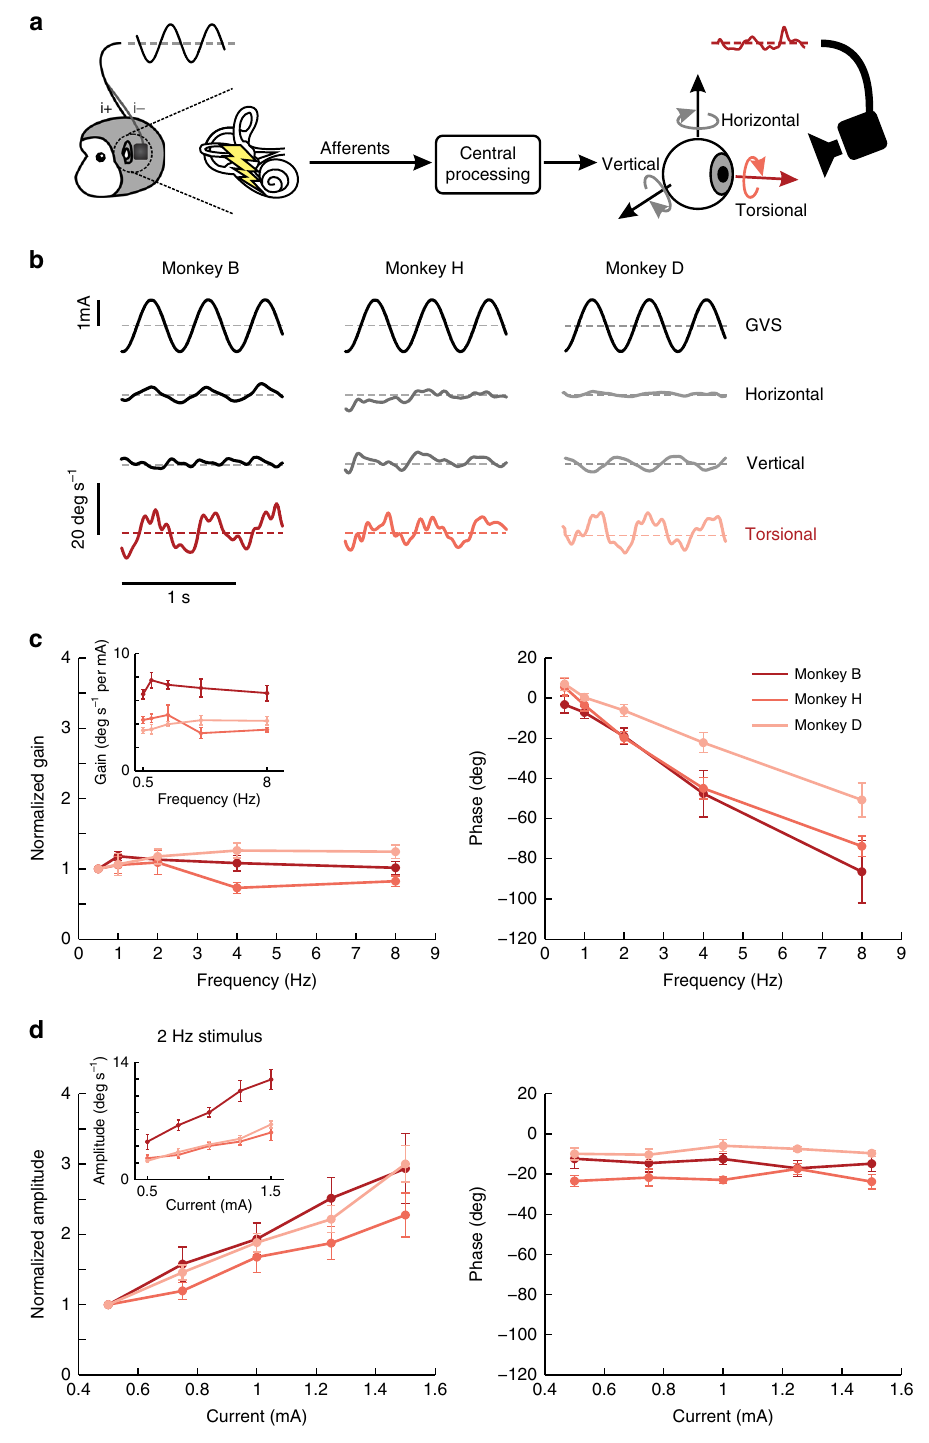
Fig. 1 Torsional eye movements in response to sinusoidal GVS. a While applying sinusoidal GVS between surface electrodes placed on the mastoid processes behind the ears, we recorded the animal ’ s eye movements while it was fi xating. b Example traces of horizontal, vertical and torsional velocity for three animals to a 2 Hz sinusoidal stimulation of 1 mA in current amplitude. Note that the primary eye component is in the torsional plane because the animals were fi xating on a target. c Average of the normalized gain and phase of the torsional eye velocity for each of the animals across fi ve trials of sinusoidal stimulation that varied in frequency. The gain was normalized based on the responses at 0.5 Hz. The inset shows the gains prior to normalization. d Average of the normalized amplitude and phase of the torsional eye velocity for each of the animals across fi ve trials of 2 Hz sinusoidal stimulation that varied in current amplitude. The amplitude was normalized based on the responses at 0.5 mA. The inset shows the amplitudes prior to normalization. Error bars depict the